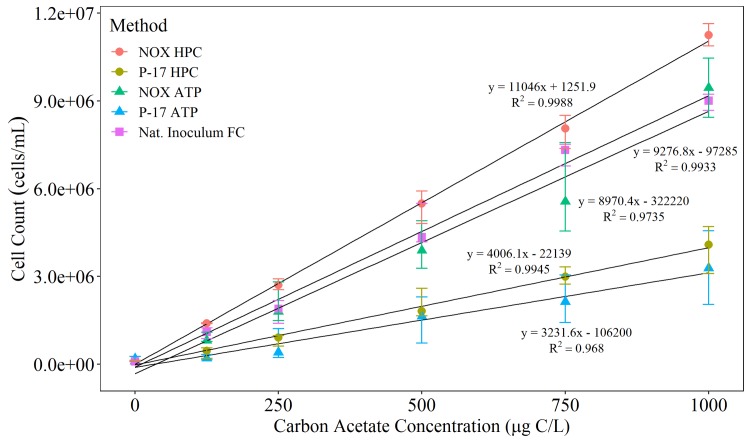
Comparison of cell counts enumerated using bacterial strains NOX (NOX HPC) and P-17 (P-17 HPC) with heterotrophic plate counts (HPC) or adenosine triphosphate (ATP), or using a natural microbial inoculum with flow cytometry (Nat Inoculum FC).HPCs are recorded as CFU / mL and total cell counts (TCC) are recorded as cells / mL. ATP luminescence units converted to cells / mL using an ATP calibration curve. The average (n = 3) cell counts (± standard deviation) at each acetate carbon concentration are plotted. The flow cytometry count refers to the total cell count.